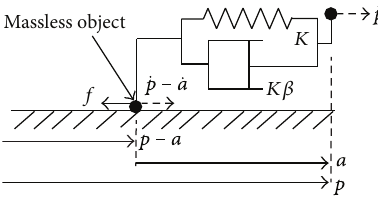
Figure 2: A physical interpretation of ((17a) and (17b)).